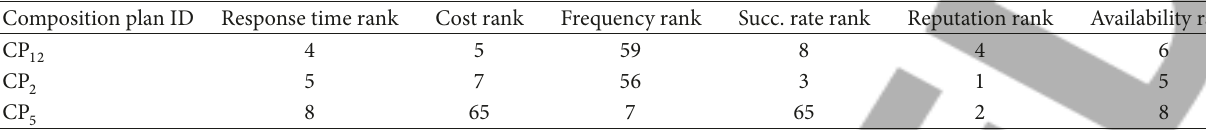
Table 5: Aggregated QoS rank example.